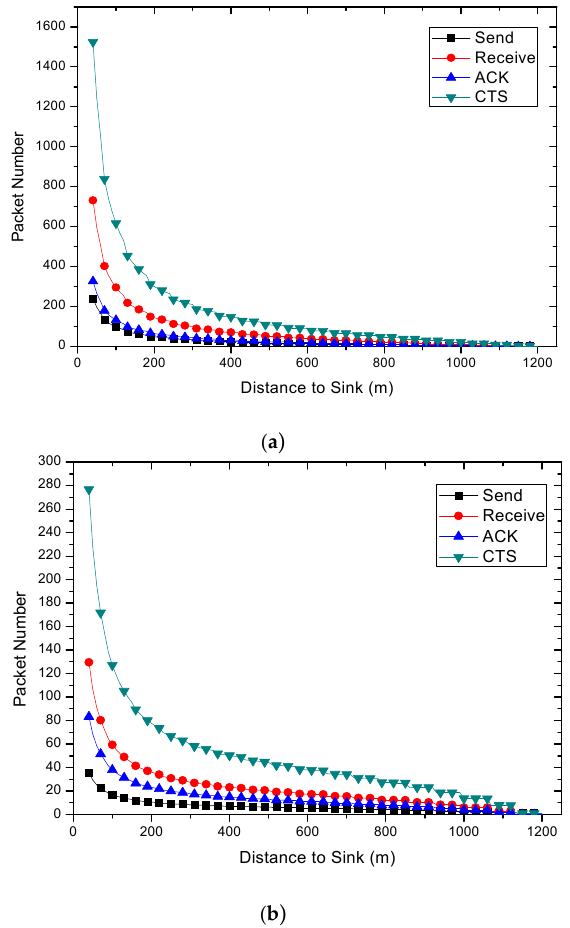
Figure 11. ( a ) Data volume of node under N = 3, r = 60; ( b ) Data volume of node under N = 3, r = 70. Combined with Equations (6)–(10), the energy consumption of nodes at different distances from sink can be calculated. The results are shown in Figures 7 and 12. Due to different network parameters, the level of energy consumption of single round may be different, so it is not intuitive enough to use the subtraction value to measure the residual energy. In this paper, the energy residual degree (cid:2019) (cid:3039) is adopted to measure the residual energy of the node (cid:1866) (cid:3039) .